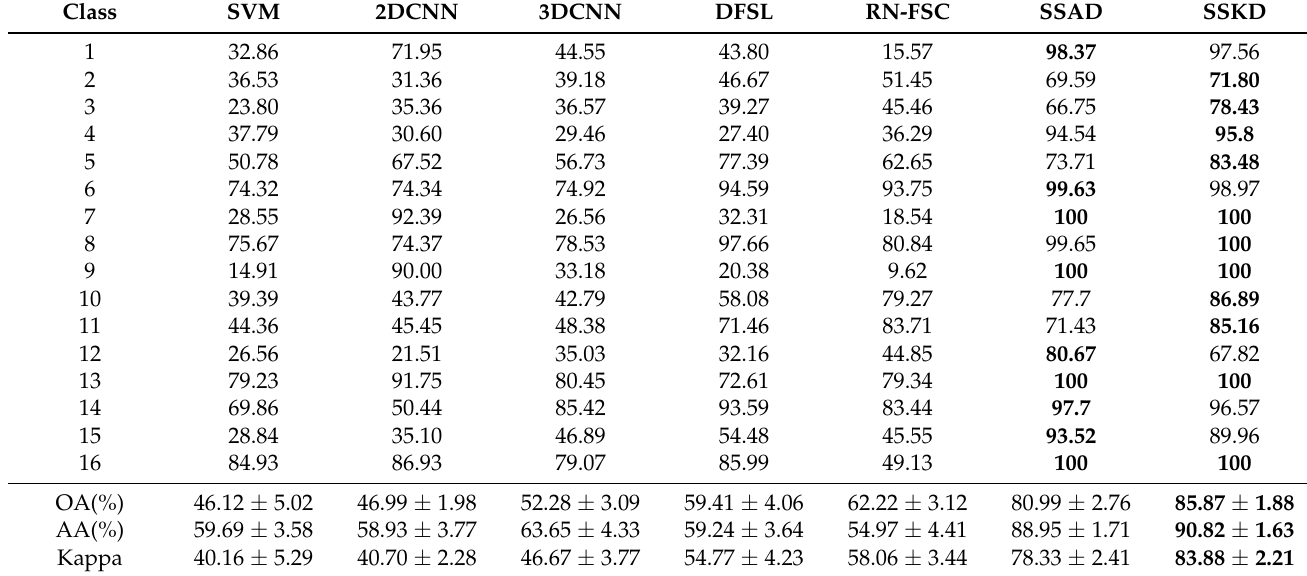
Table 5. The classification accuracy of several different methods on the IP dataset, with five labeled samples for each category. The best accuracy is shown in bold.